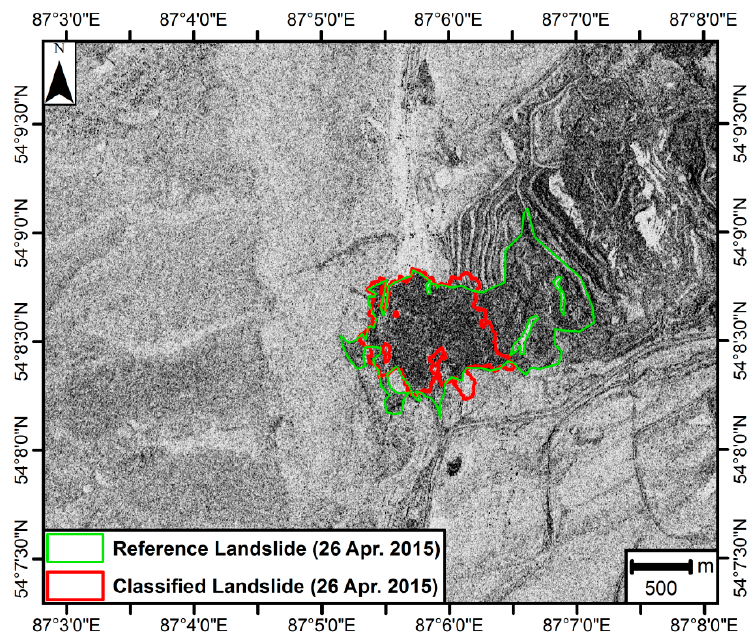
Figure 8. Result (red) of the landslide detection procedure at the Russian mining waste site based on post-event dual-pol TerraSAR-X (acquired on 26 April 2015; background image) and pre-event optical Landsat-8 (14 September 2014) imagery. Green: Reference derived by visual interpretation and manual digitization of the TerraSAR-X imagery. TerraSAR-X © 2015 German Aerospace Center (DLR), 2015 Airbus Defence and Space/Infoterra GmbH.